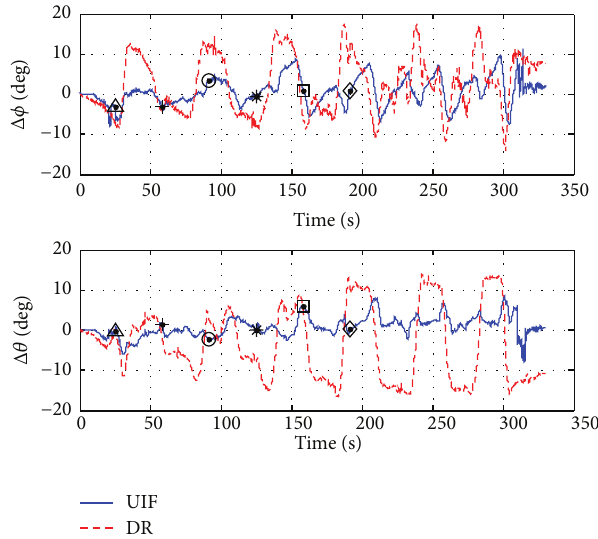
Figure 11: Simplified formulation attitude estimates with dead reckoning (DR) for Flight #2. Table 3: Flight #2 error statistics for estimated states. Estimated state Mean abs.